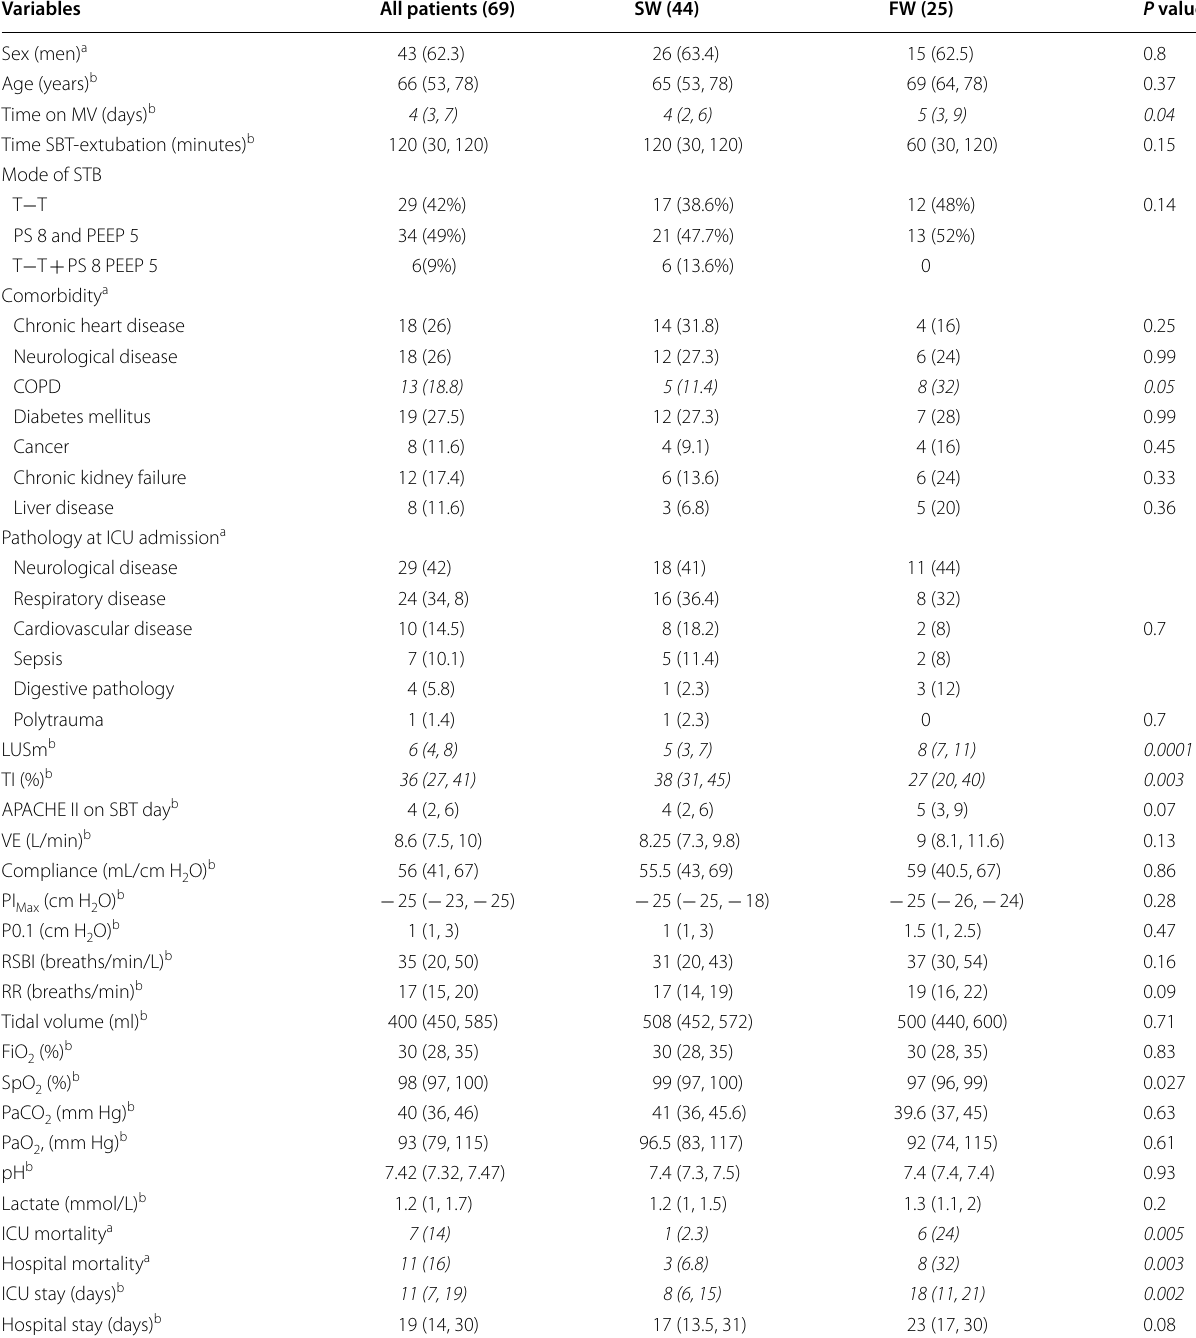
Table 1 Characteristics of patients included in the